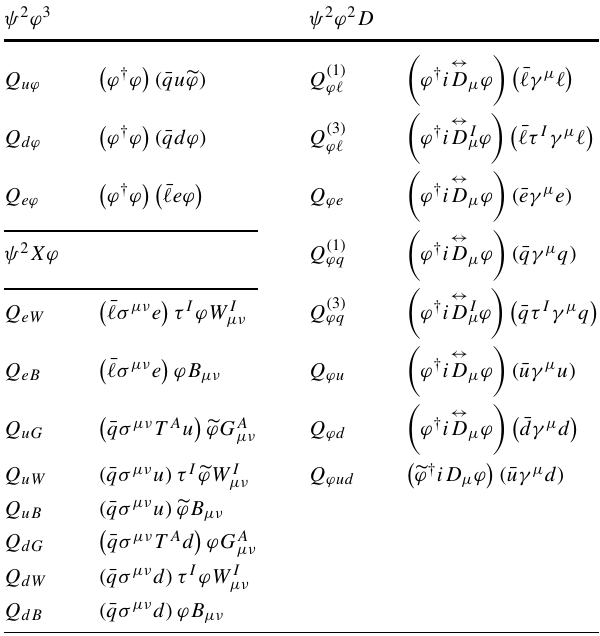
Table 6 SMEFT purely fermionic operators which preserve Baryon number